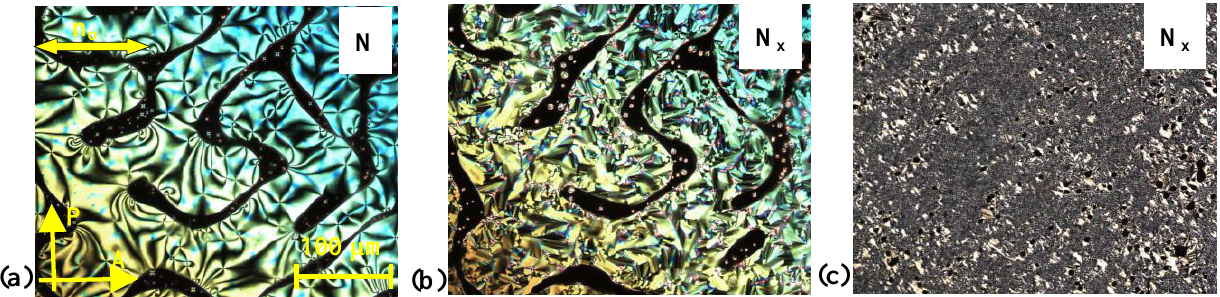
Figure 16. Textures of the binary mixture, MGTP211 (15% (w/w) 4 in 85% CB_C9_CB ), between untreated glasses observed in the same region upon cooling between crossed polarizers: ( a ) schlieren texture in the high-temperature nematic N phase at 113 °C; ( b ) fan-like texture of the low-temperature N phase at 100 °C; and ( c ) sheared texture of x the low-temperature N phase at 84 °C. x